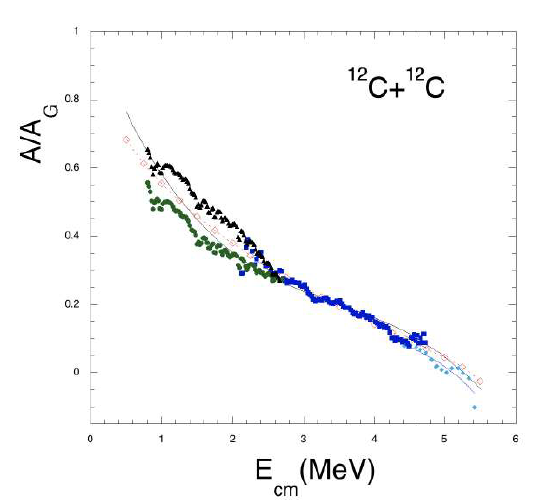
Figure 4. Normalized sub barrier action, symb 3. The dashed line is the fit to the model using e line is the fit to the direct data of ref.[7] and the